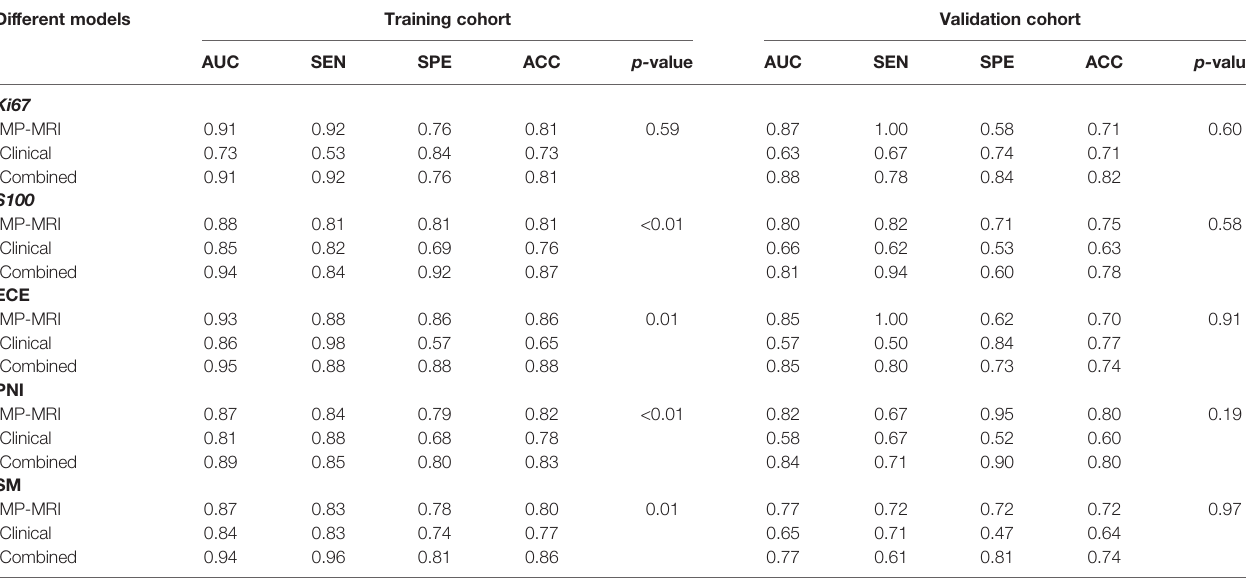
TABLE 2 | Diagnostic performance of optimal models for each group.